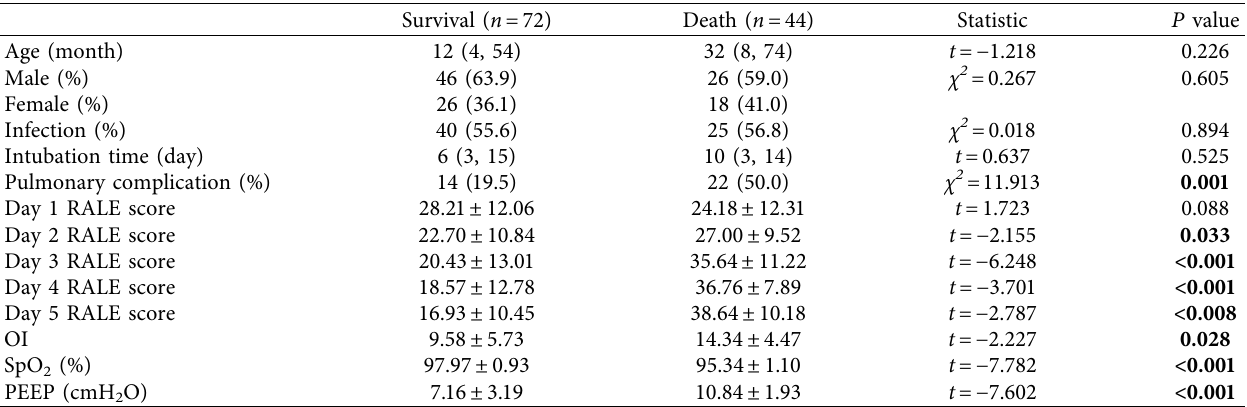
Figure 2: Selection process of patients.116 patients of the 271 were enrolled. ECMO, extracorporeal membrane oxygenation; CXR, chest X- ray. Table 1: Comparison of survival and death